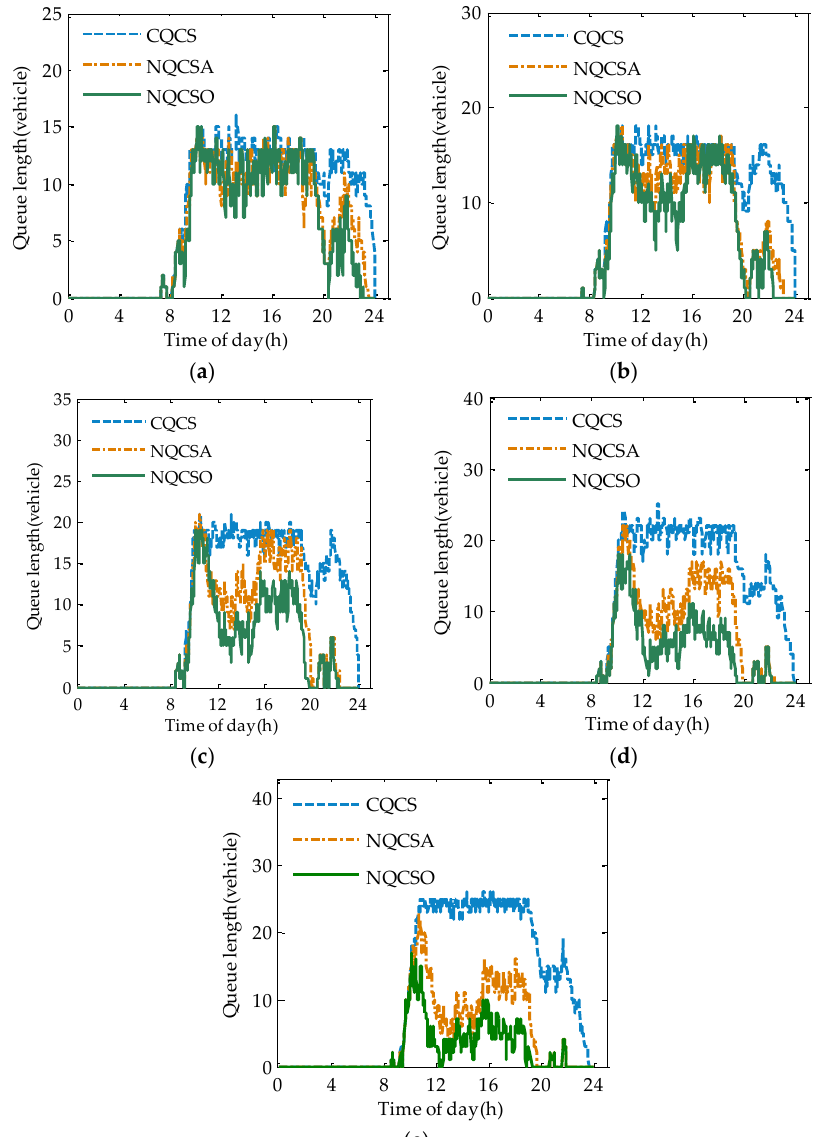
Figure 11. Queue length given different numbers of chargers in different charging conditions: ( a ) four chargers; ( b ) five chargers; ( c ) six chargers; ( d ) seven chargers; ( e ) eight chargers.